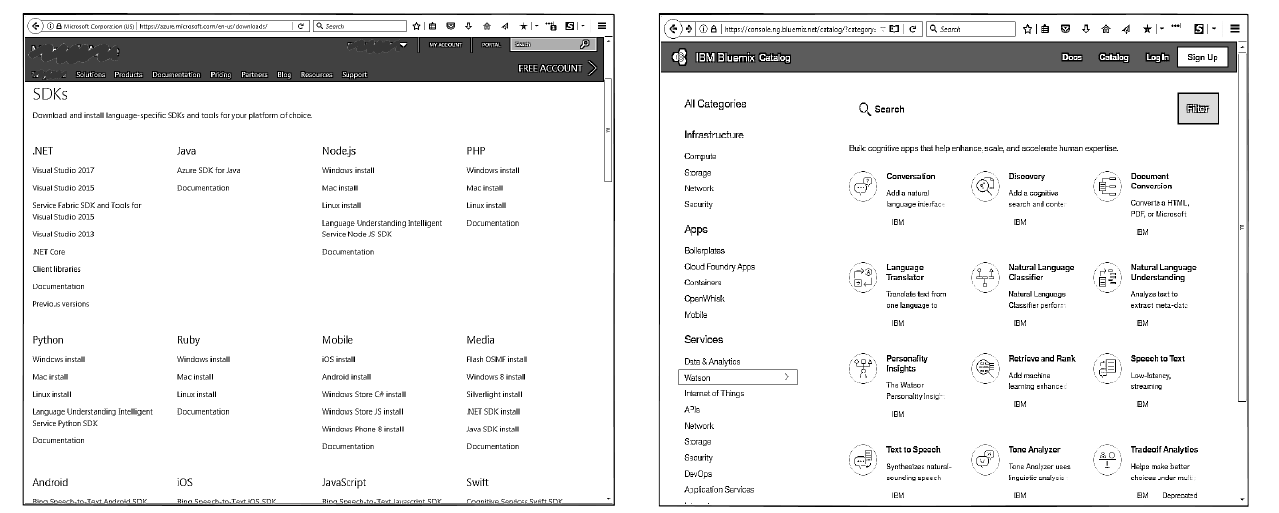
Fig. 18. IBM Bluemix services listing, with tags identifying third party, community and IBM maintained components.